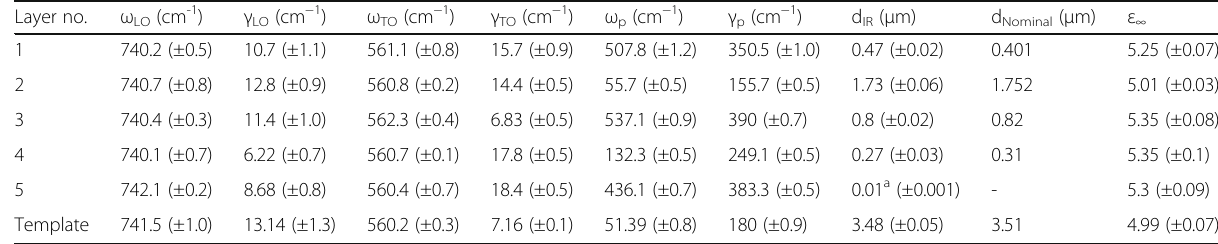
Table 1 Best fit oscillator parameters for GaN layers of the investigated structure (layers are numbered from top to bottom) Layer no.